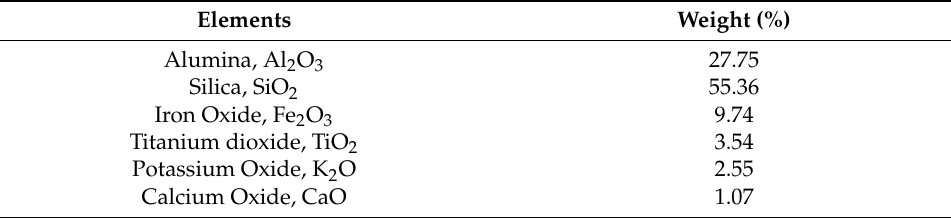
Table 1. Chemical composition of fly ash.